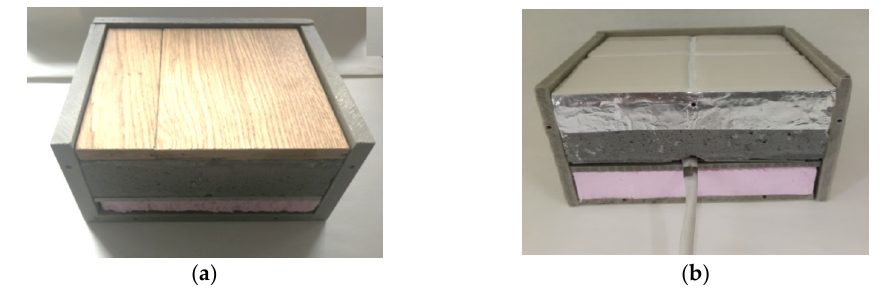
Figure 2. The housing of a heated floor sample type D (dry rooms). Figure 3. Cross-section of the heated floor sample ( a ) type D ( b ) type W (wet rooms).